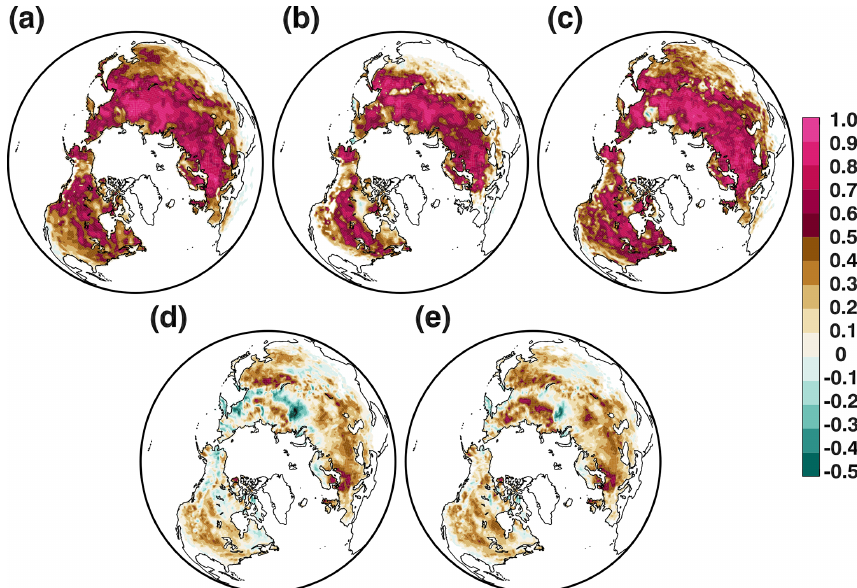
Figure 9. Correlation maps (2002–2010) for four reanalysis-driven products (Crocus, GLDAS-2, ERA-Interim/Land, and MERRA-2) relative to (a) each other (mean correlation between the four reanalysis-driven products), (b) GlobSnow v2.0, (c) ERA5, (d) NASA AMSR-E SWE v1.0, and (e) NASA AMSR-E SWE